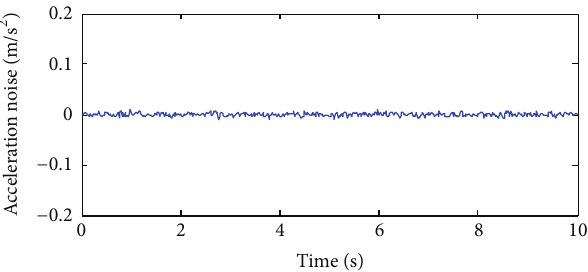
Figure 16: The acceleration noise with 10% noise